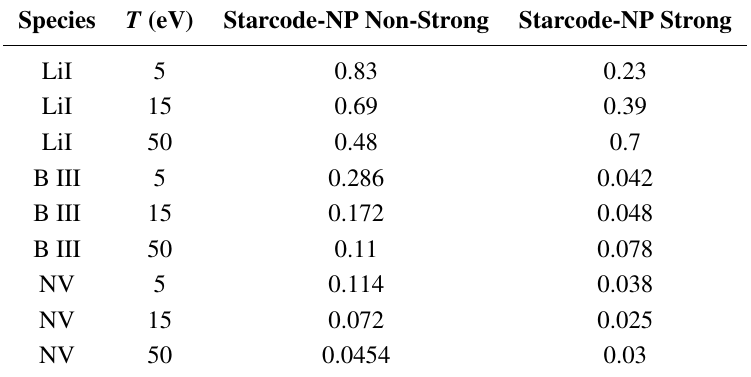
Table 2. 2s-2p Transition width (FWHM) strong collision importance in Starcode-NP. All widths are in cm − 1 and normalized to a density of 10 17 e/cm 3 . Species T (eV) Starcode-NP Non-Strong Starcode-NP Strong LiI